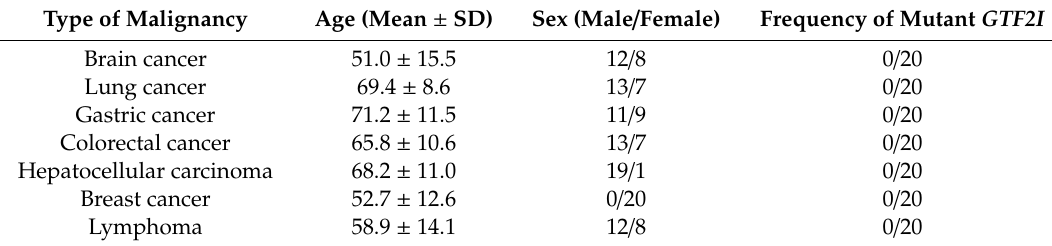
Table 3. The Presence of Mutant GTF2I in Other